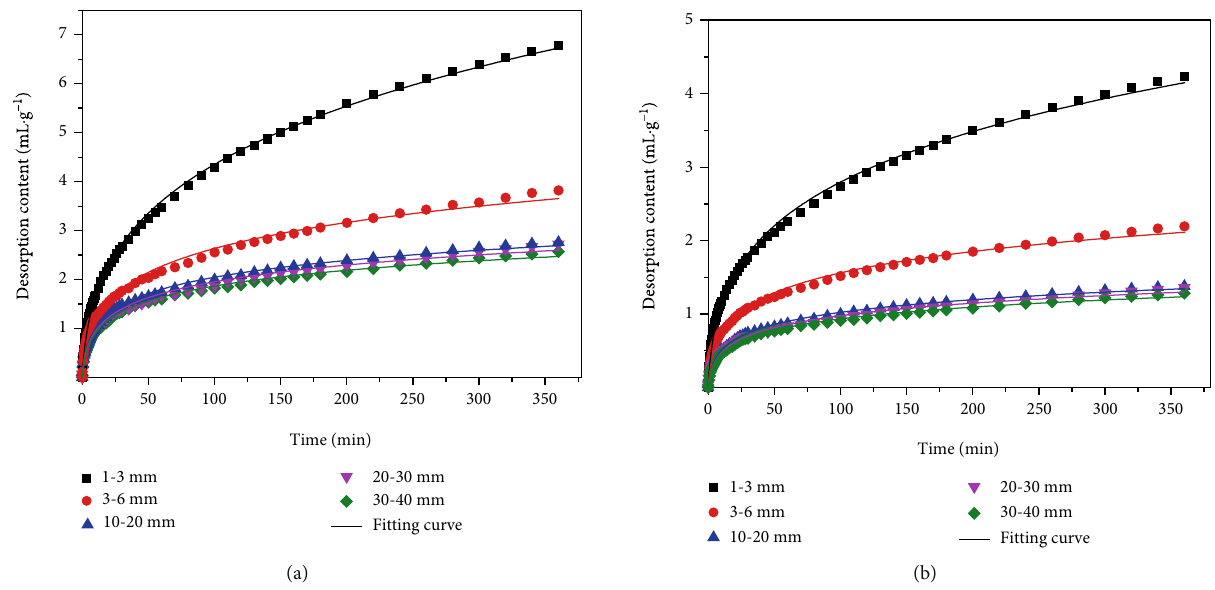
Figure 5: Relationship between the desorption content and time for di ff erent particle sizes: (a) positive pressure of 0.5MPa and (b) positive pressure of 1 MPa.